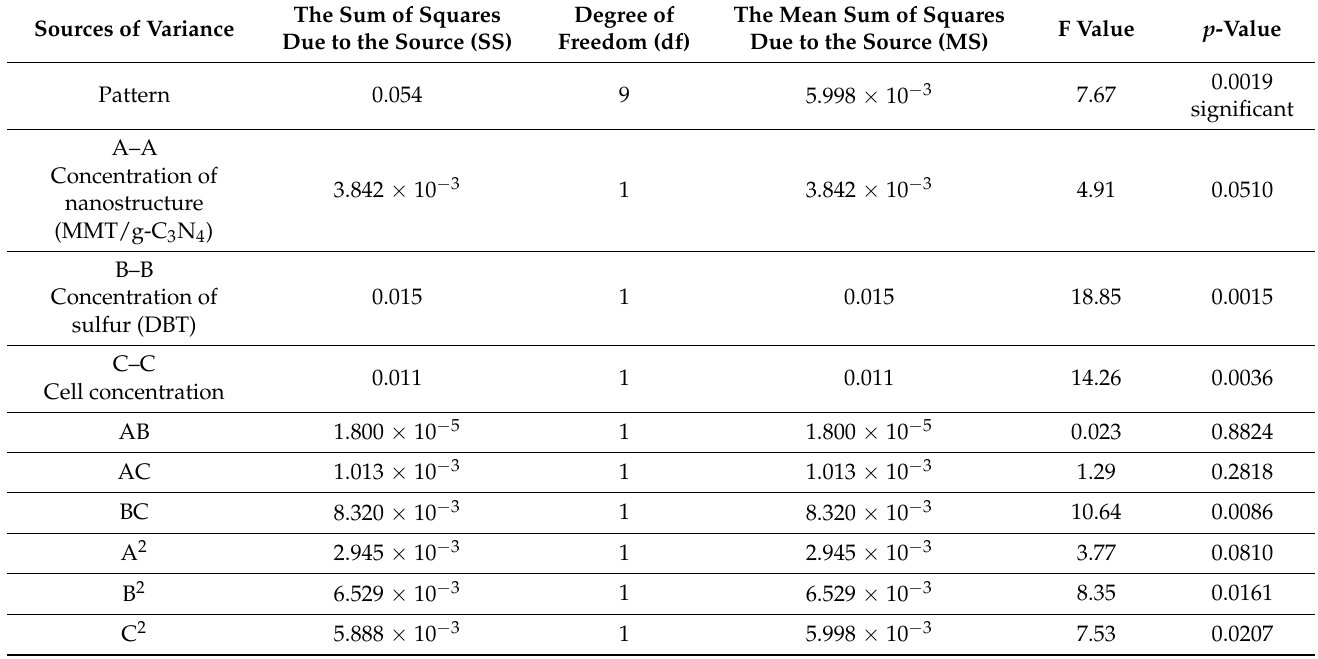
Table 5. ANOVA for evaluation of R 1 for Rhodococcus erythropolis IGTS8 in the presence of the nanostructure.